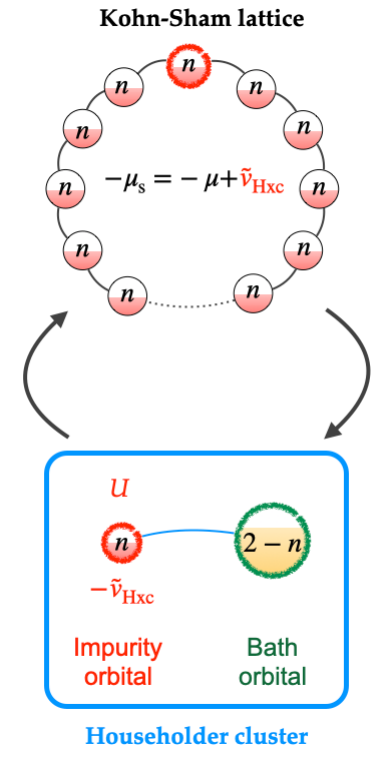
Figure 1. Graphical representation of the LPFET procedure. Note that the same Hxc potential ˜ v Hxc is used in the KS lattice and the embedding Householder cluster. It is optimized self-consistently in order to fulfill the density constraint of Equation (85). See text for further